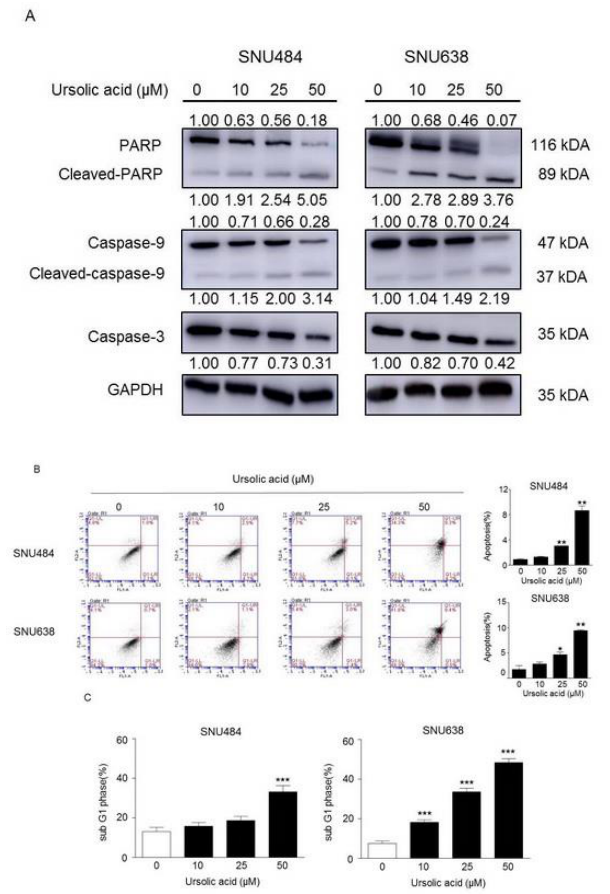
Figure 3. E ff ects of UA on cell apoptosis. SNU484 and SNU638 cells were treated with UA (0, 10, 25, and 50 µ M). ( A ) The apoptosis-regulatory factors cleaved-PARP, PARP, cleaved-caspase-9, caspase-9, and caspase-3 were measured after UA treatment (0, 10, 25, and 50 µ M) while using Western blot analysis in SNU484 and SNU638 cells. PARP, caspase-9, and caspase-3 were significantly decreased, whereas cleaved-PARP and cleaved-caspase-9 were significantly increased in a dose-dependent manner.